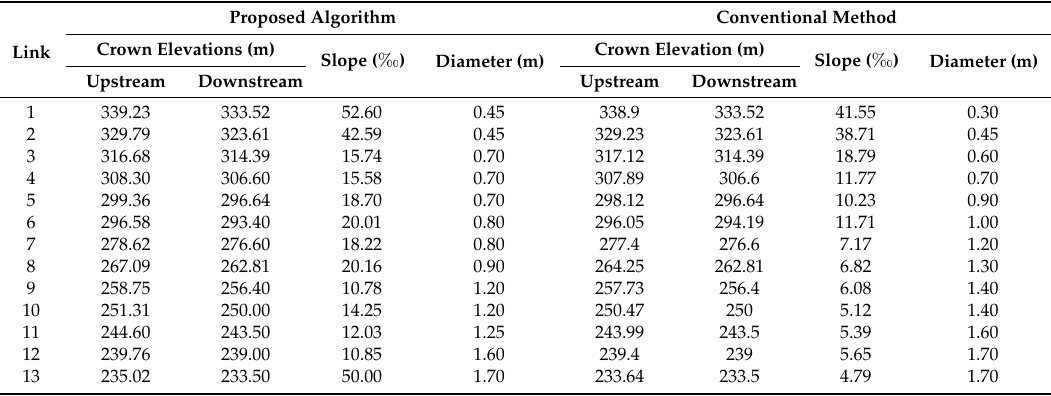
Table 3. Comparison of the results for the proposed method and the conventional procedure.